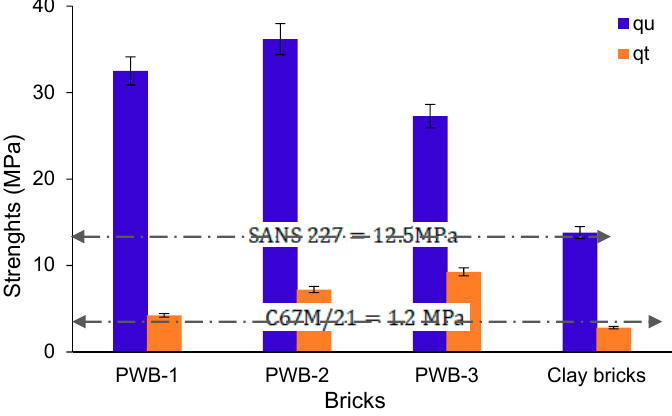
Figure 6. The q u and q t of studied bricks.